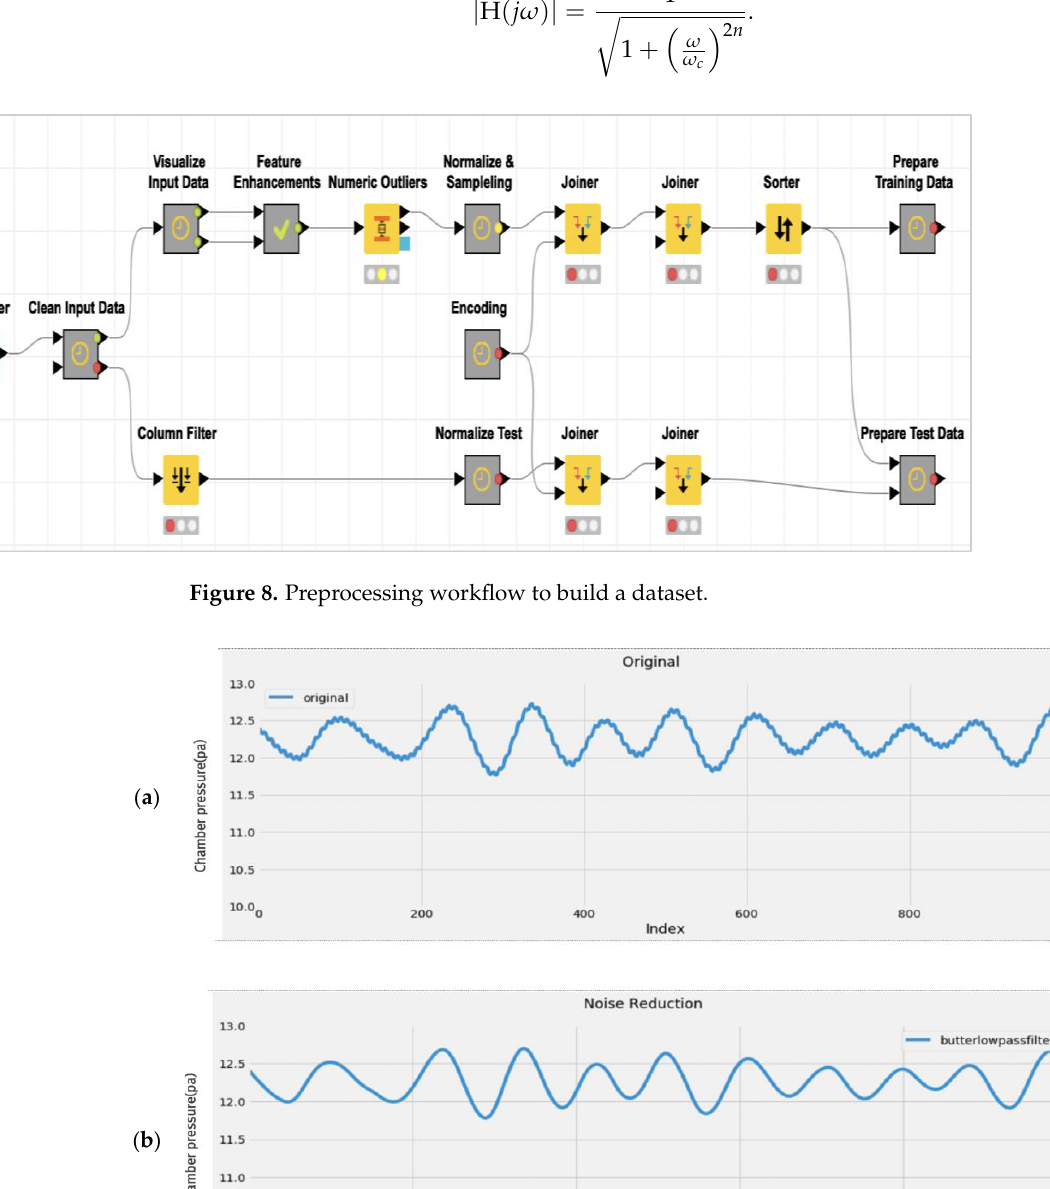
Figure 10. Result of autocorrelation analysis. The datasets for ML can be largely classified into training sets and test sets, and if a sufficient volume of data is acquired, the datasets can be classified into training sets, test sets, and validation sets, additionally enabling validation of data. Each type of dataset can